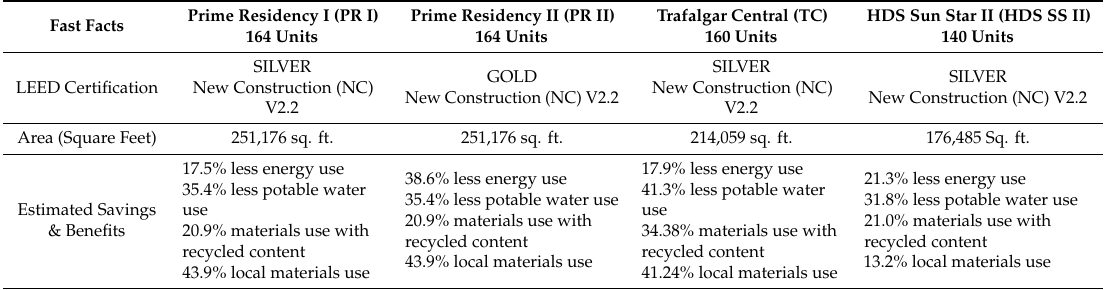
Figure 5. HDS Sun Star II (HDS SS II), International City, Dubai, UAE. Table 1. Information regarding 4 LEED-certified residential buildings.